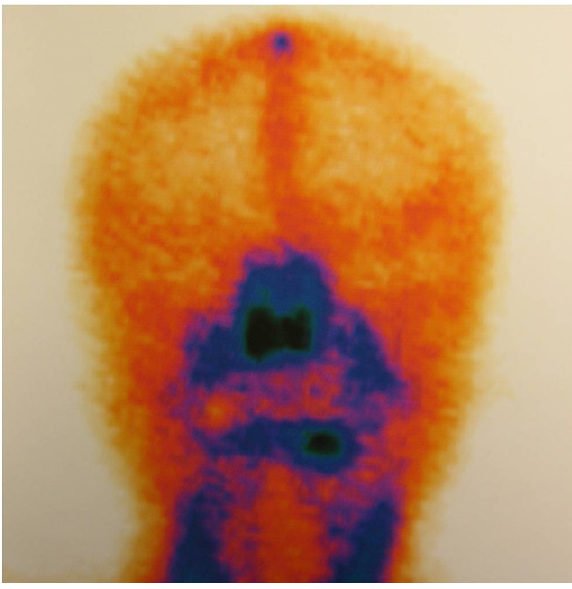
Figure 2: Tc red blood cell scintigrafy of the